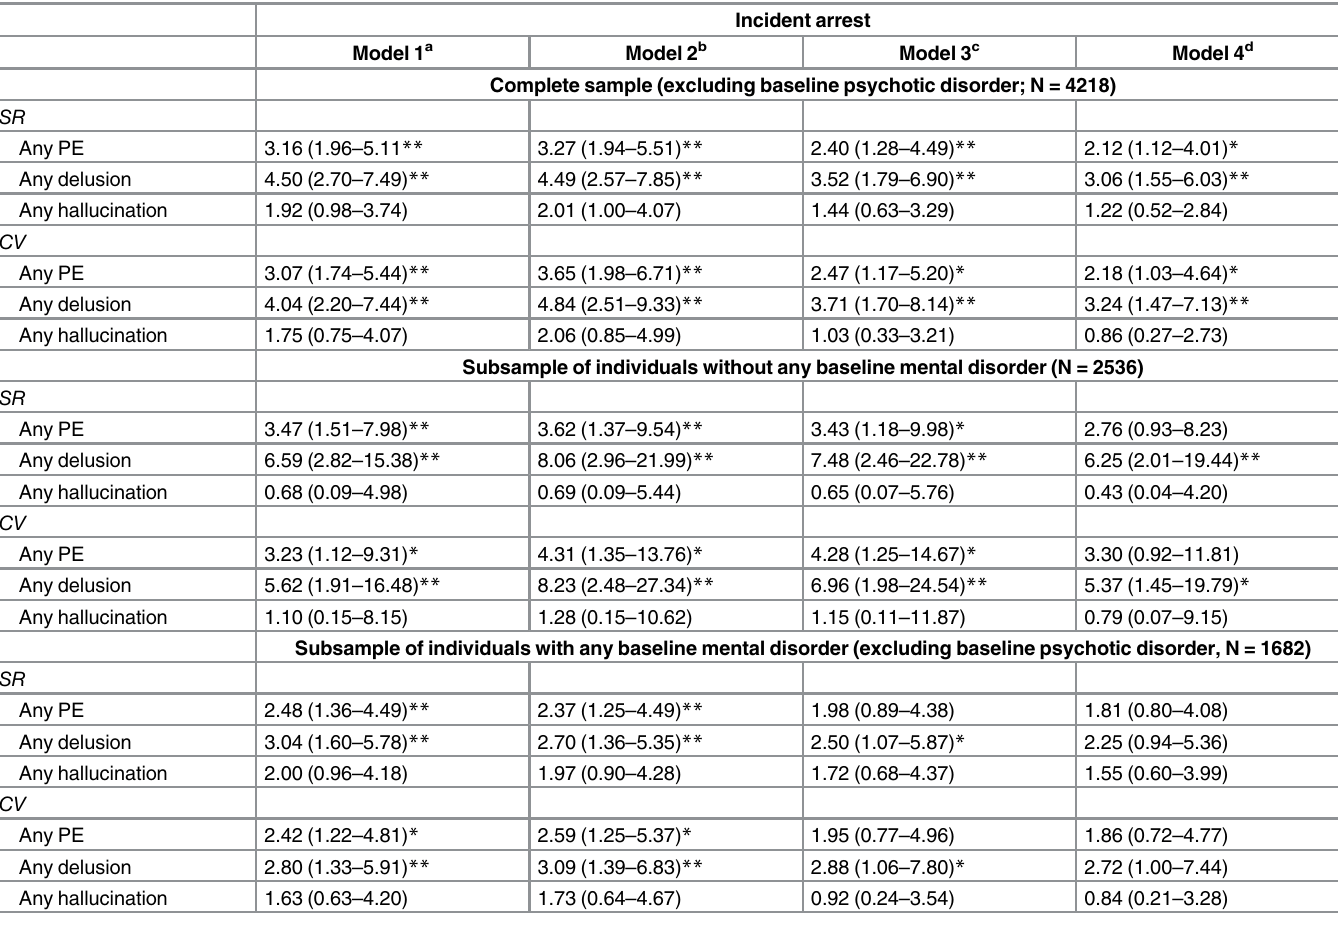
Table 4. Results (odds ratios and 95% CI) from logistic regression analyses on the association between self-reported (SR) and clinically validated (CV) psychotic experiences and three-year incidence of arrest in a general population sample and two